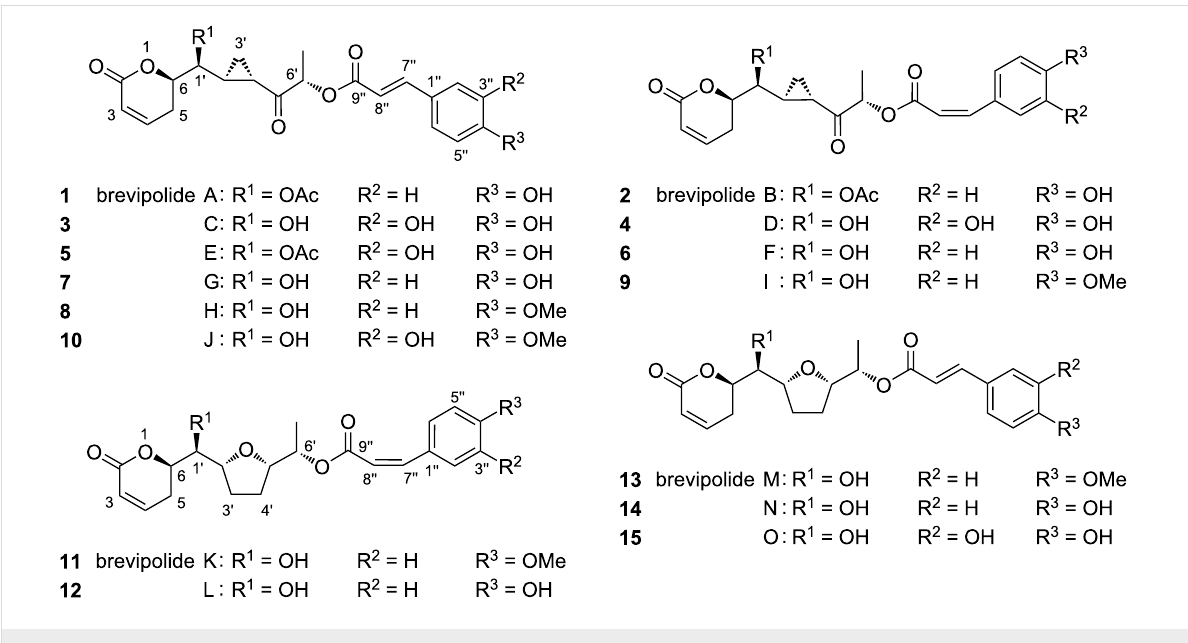
Figure 1: Structures of brevipolides A–O ( 1 – 15